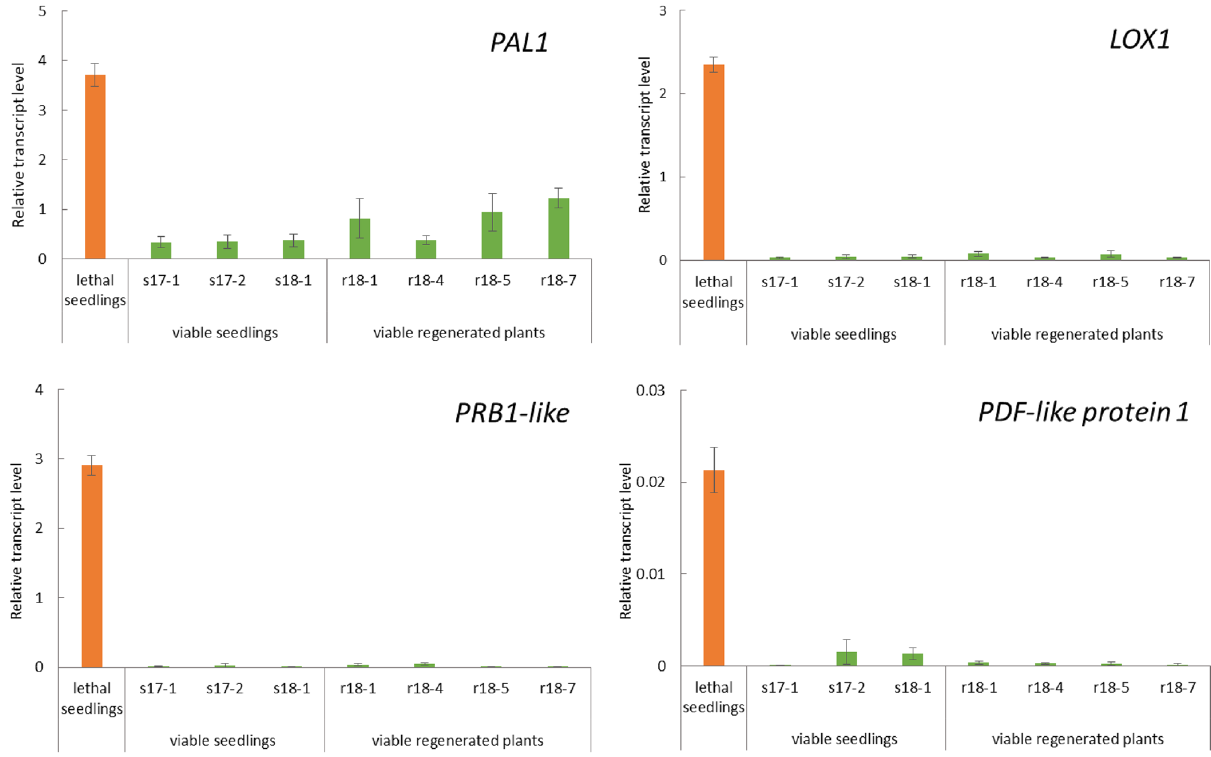
Figure 3. Relative transcript levels of immune response-related genes in cotyledons of lethal seedlings (at 6 days after germination (DAG)) and in young true leaves of viable seedlings (s17-1, s17-2, and s18-1) and viable regenerated plants (r18-1, r18-4, r18-5, and r18-7) of the N. suaveolens x × N. tabacum cross. Quantitative Real- Time-Polymerase Chain Reaction (qRT-PCR) was used to determine transcript levels of PAL ( Phenylalanine ammonia lyase ) 1 , PRB ( Basic form of Pathogenesis-related protein ) -1 like , LOX ( Lipoxygenase ) 1 , PDF ( Plant defensin ) -like protein 1 relative to those of RFC3 (a housekeeping gene). Data are shown as the mean ± SE from triplicate samples (n = 3) for each treatment.